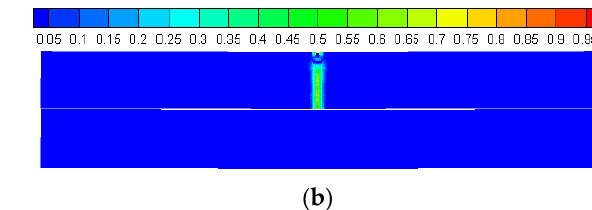
Figure 7. Damage of the laminated glass at t = 7.5 μ s: ( a ) FDEM; ( b ) Peridynamics (Adapted from Ref. [43]).